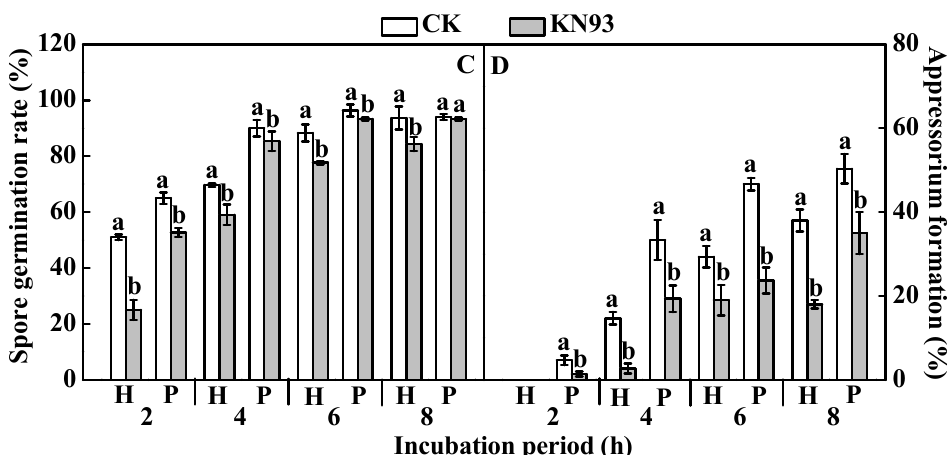
Figure 8. A. alternata spore germination and appressorium formation following treatment with KN93. ( A ) A. alternata spore germination at different KN93 concentrations; ( B ) A. alternata appressorium formation at different KN93 concentrations; ( C ) A. alternata spore germination following treatment with KN93 under hydrophobic (H) and pear wax (P) substrates; ( D ) A. alternata appressorium formation following treatment with KN93 using hydrophobic (H) and pear wax (P) substrates. The ddH 2 O was used as a control. The vertical line indicates a standard error (±SE). Different letters indicate significant differences ( p < 0.05).